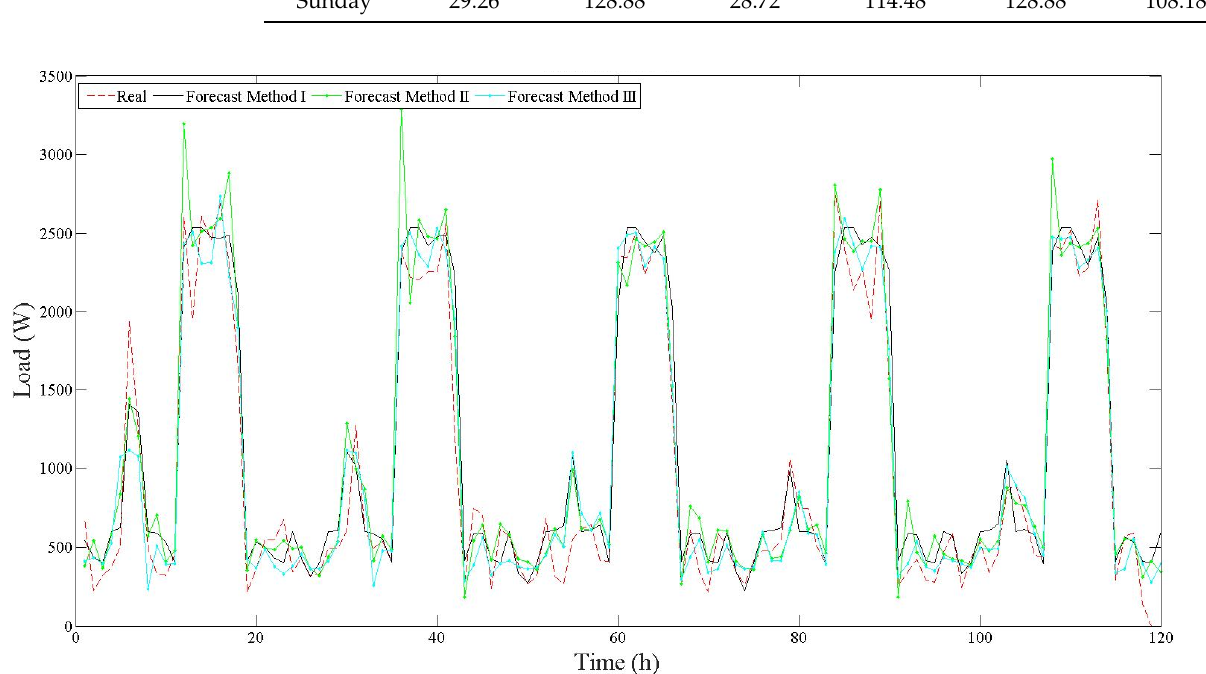
Figure 5. Forecast hourly load of working days of household No 71. Figure 6 demonstrates the error forecast during the training process. The three methods demonstrate an acceptable error for energy household forecasting.